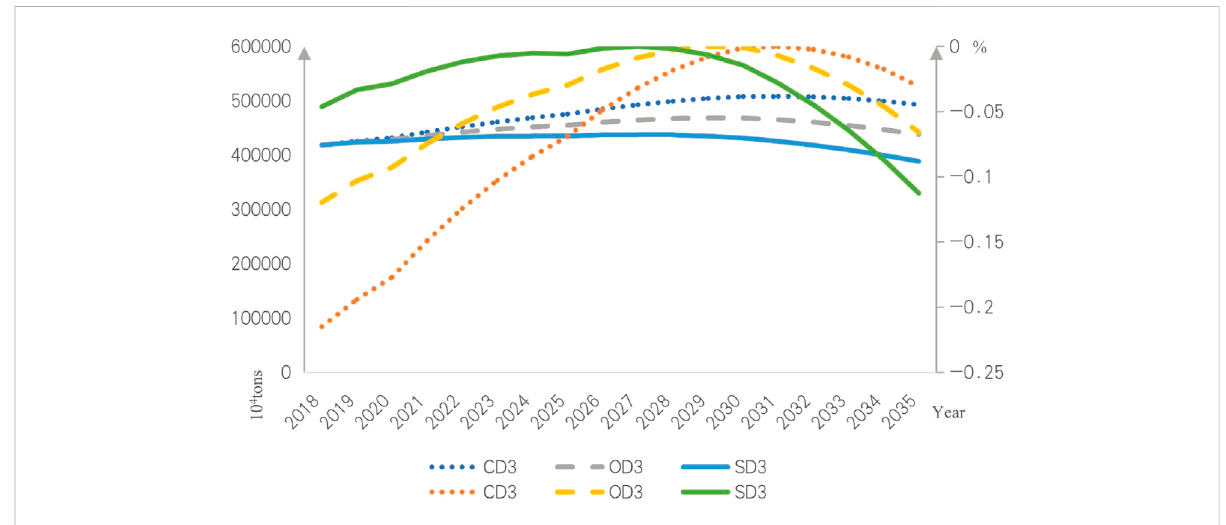
FIGURE 9 Gap between China ’ s coal consumption and peak value under CD3-OD3-SD3 scenario from 2018 to